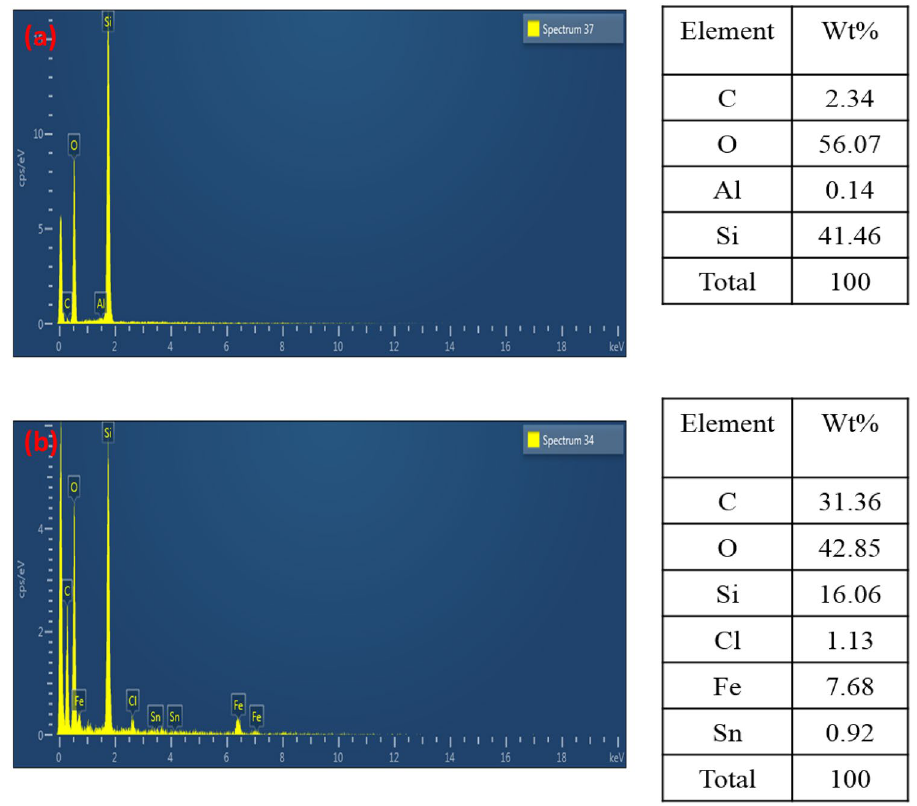
Figure 5. EDX of ( a ) Feldspar (catalyst support) ( b ) Fe/SnO/Feldspar.